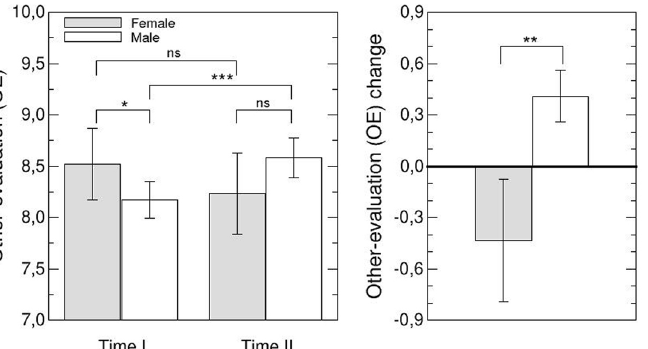
Fig 1. Analysis of other-evaluation index (OE). The left plot shows mean OEs at Time I and Time II for male and female leaders(see legend).Error bars indicate the mean standard error. The right plot shows OE changesfor male and female leaders. Significance is definedas follows: ns–not significant; * p < .1; ** p < .05; *** p < .001.